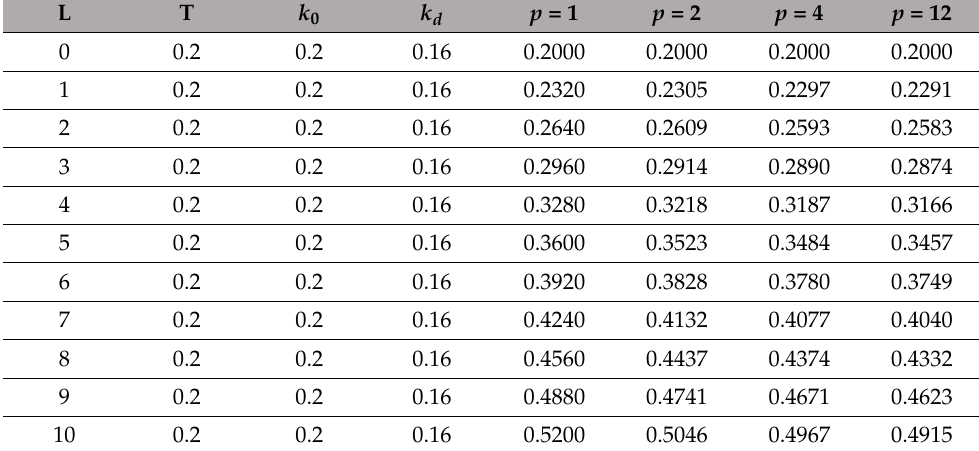
Table A9. Dependence of the equity cost, k e , on leverage level L at fixed k d = 0.16 and at different p =